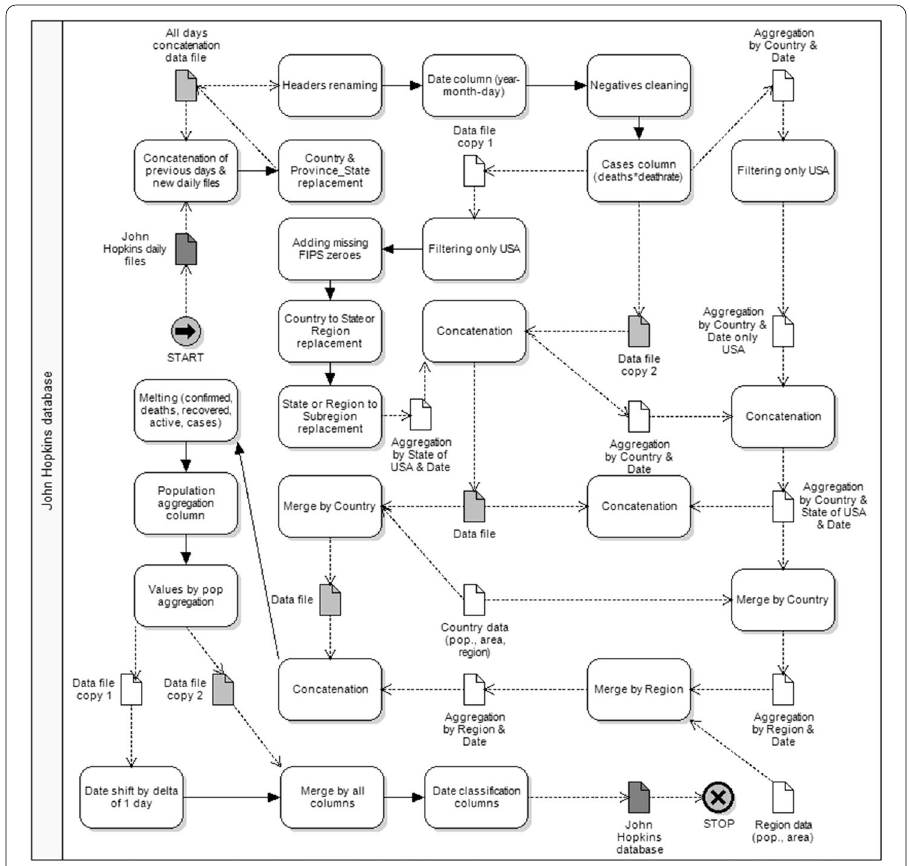
Fig. 1 John Hopkins University data processing